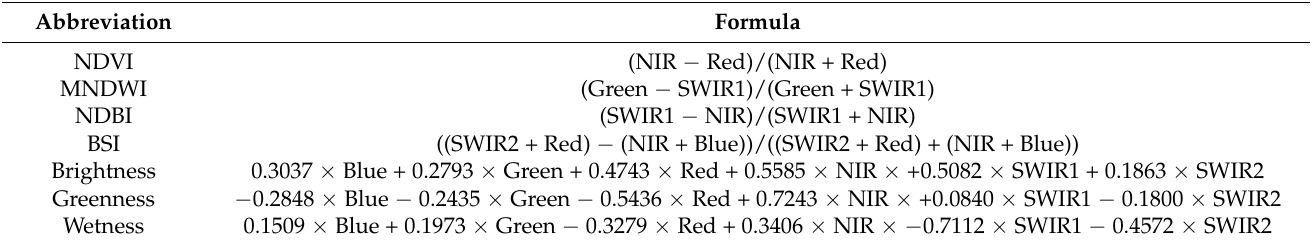
Table 2. Calculation equations of normalized difference indices and component variables from tasseled cap transform